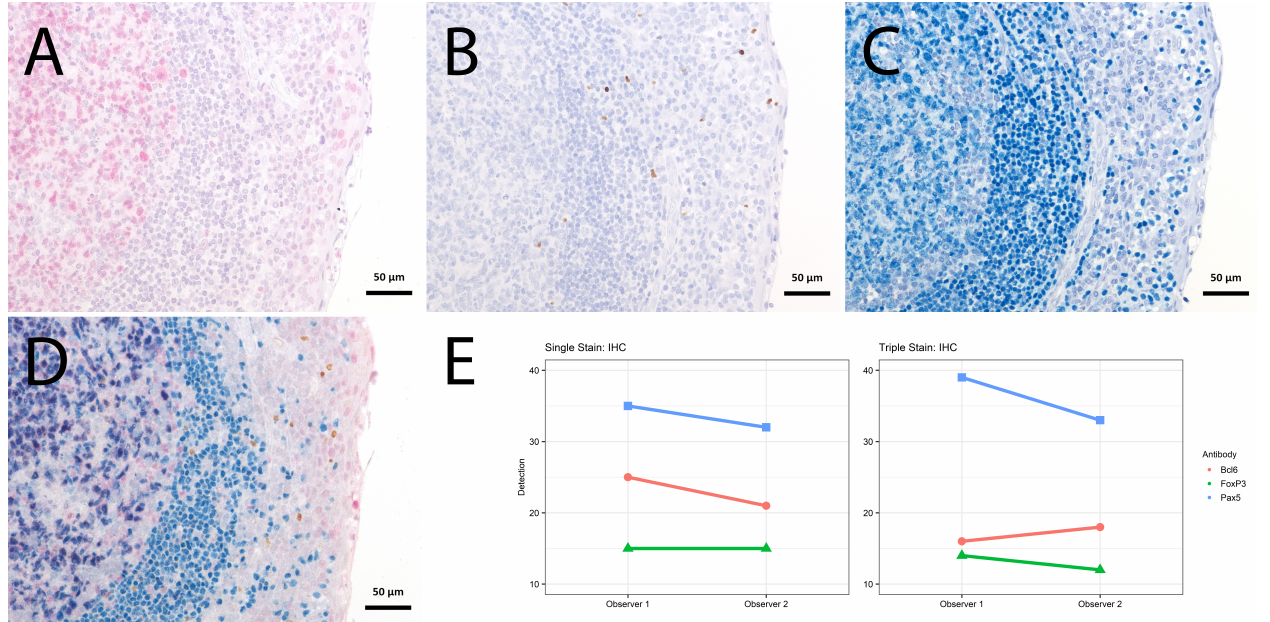
Figure 4. Single vs. triple stainings, immunohistochemistry on tonsil sections. ( A – C ) Single stainings: ( A ) Bcl6 red after 15 min TRIS pH9, ( B ) FoxP3 brown after 20 min TRIS pH6.1, ( C ) PAX5 blue after 20 min TRIS pH6.1. ( D ) Human tonsil with triple staining IHC, according to the FOLGAS protocol: Bcl6 red, FoxP3 brown, PAX5 blue; antigen retrievals equivalent to the corresponding single staining. Magnifications indicated by bar. ( E ) Sum of H-scores of the respective stainings under single and triple staining conditions, from two independent observers.